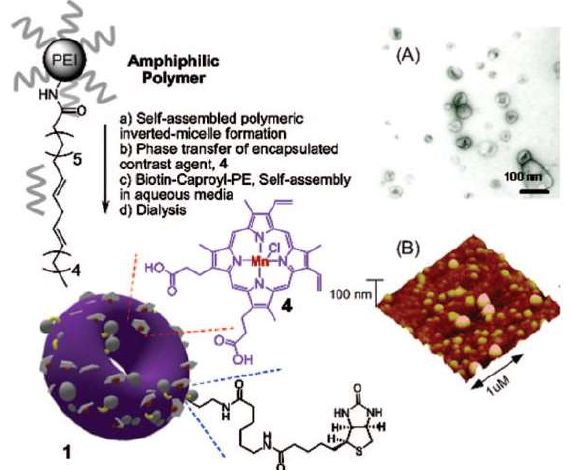
Figure 9. Schematic illustration of the synthesis, ( A ) transmission electron microscopy (TEM) and ( B ) atomic force microscopy (AFM) images of a Mn(III)-labeled nanobialy. 1. nanobialys and 4. Sensitizers numbered in the original figure. Reproduced from [44] with permission from Journal of the American Chemical Society ,